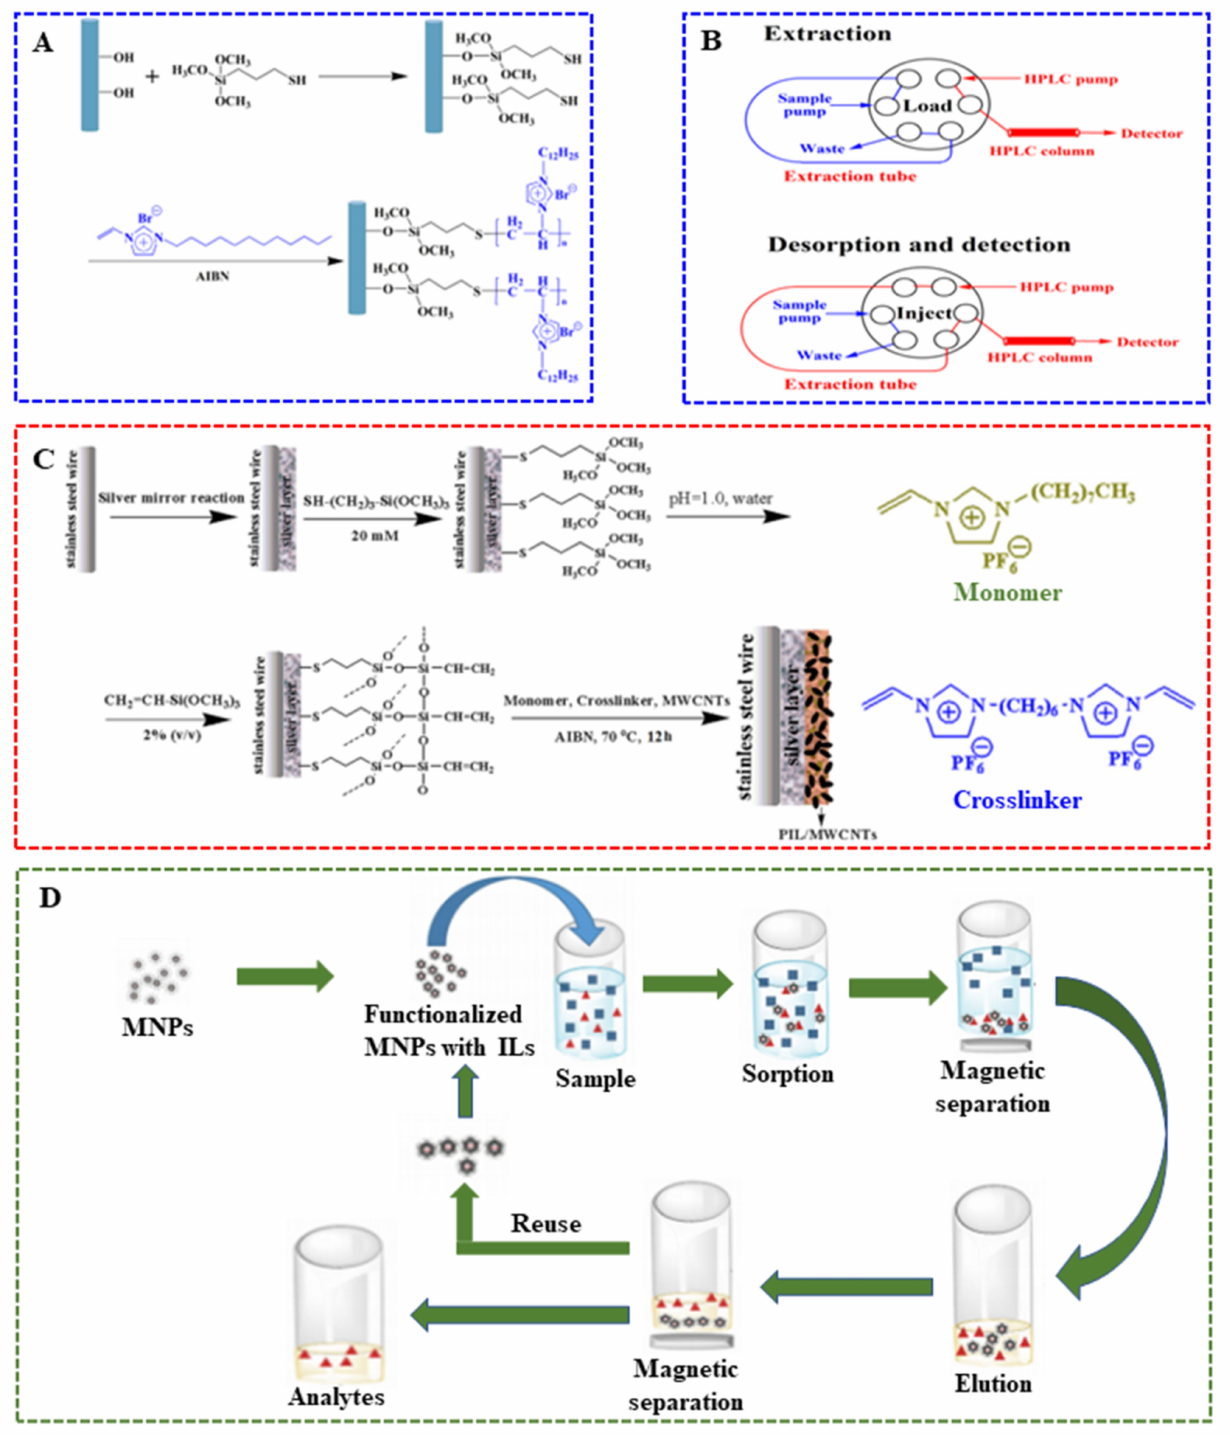
Figure 4. ( A ) Non-covalent functionalization of oxidized MWCNTs with PIL; ( B ) Construction of in-tube SPME-HPLC online system by a switchable six-port injection valve; ( C ) Preparation of PIL/MWCNTs-coated SPME fiber; ( D ) Application of MNPs in the M-DMSPE [131,136,137]. In addition to the coat of ILs over the SPME sorbent, a flat thin film can be coated over the solid support to form a multilayered SPME fiber, which has high surface area-to-volume ratio and promoting kinetics. The thin film possesses a membrane polymer matrix with the incorporated-selective carrier. The above system is referred to as membrane-based